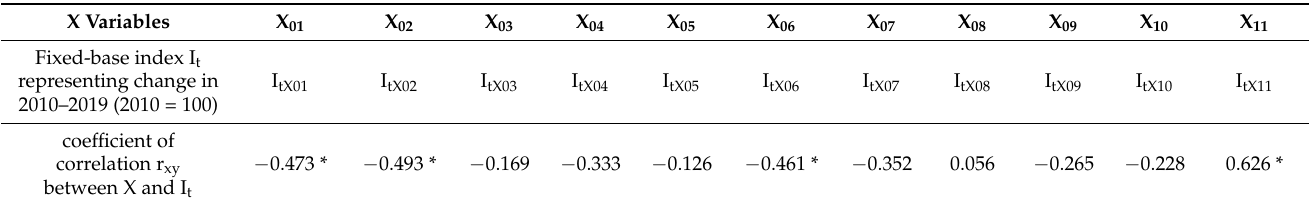
Table 8. Correlations of variables characterising energy consumption, means of energy consumption reduction and greenhouse gas emissions from energy in 2019 (variables X 01 –X 11 ) and the index I t representing change of values of these variables in 2010–2019 (2010 = 100) in EU (27) countries.